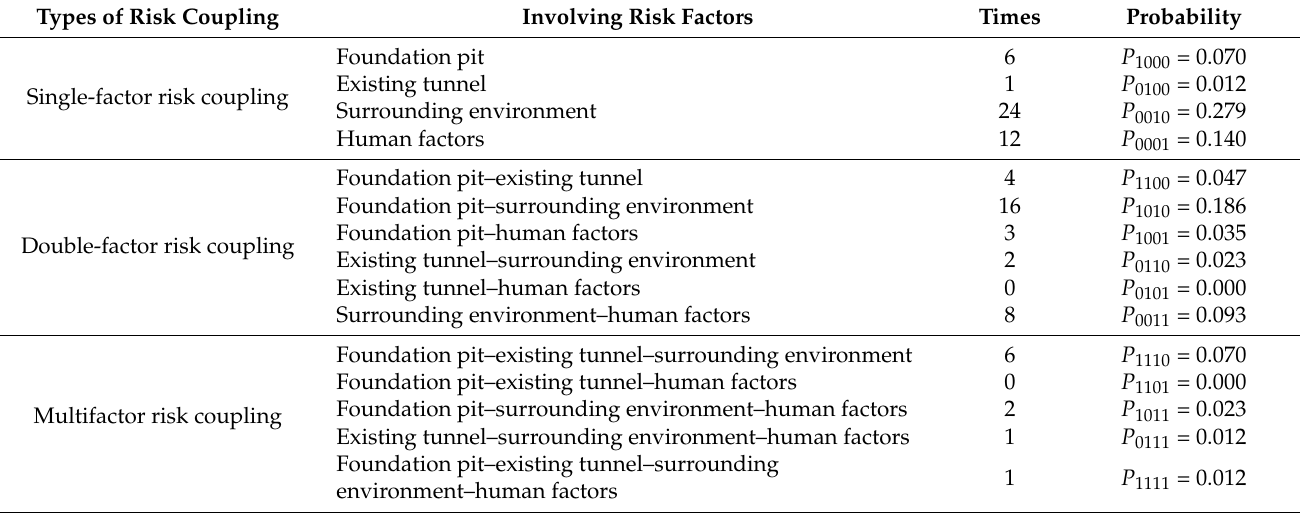
Table 5. Risk coupling frequency and probability for 86 cases.